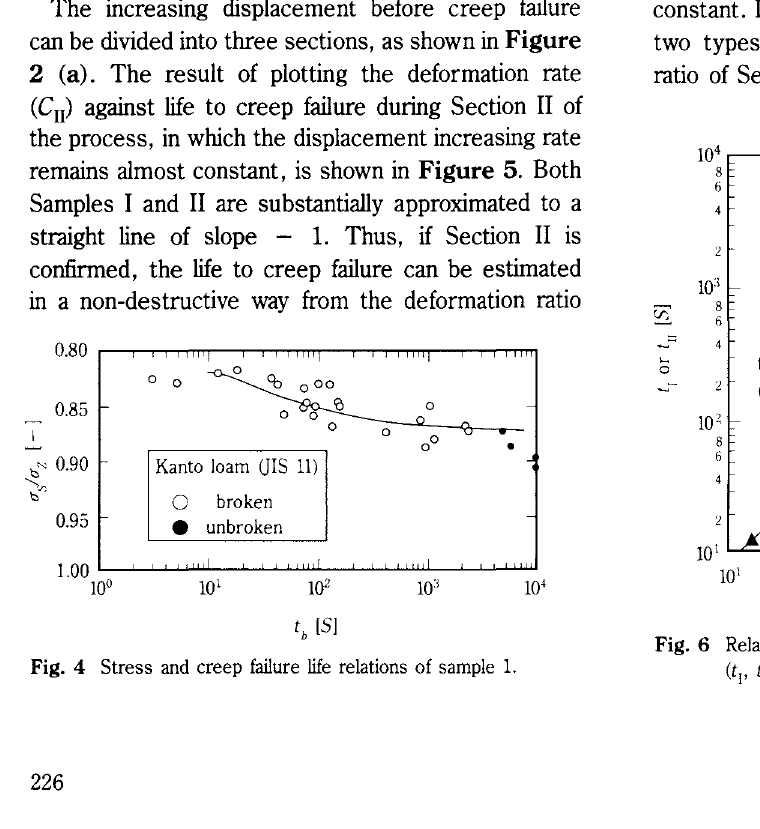
Fig. 4 Stress and creep failure life relations of sample 1.